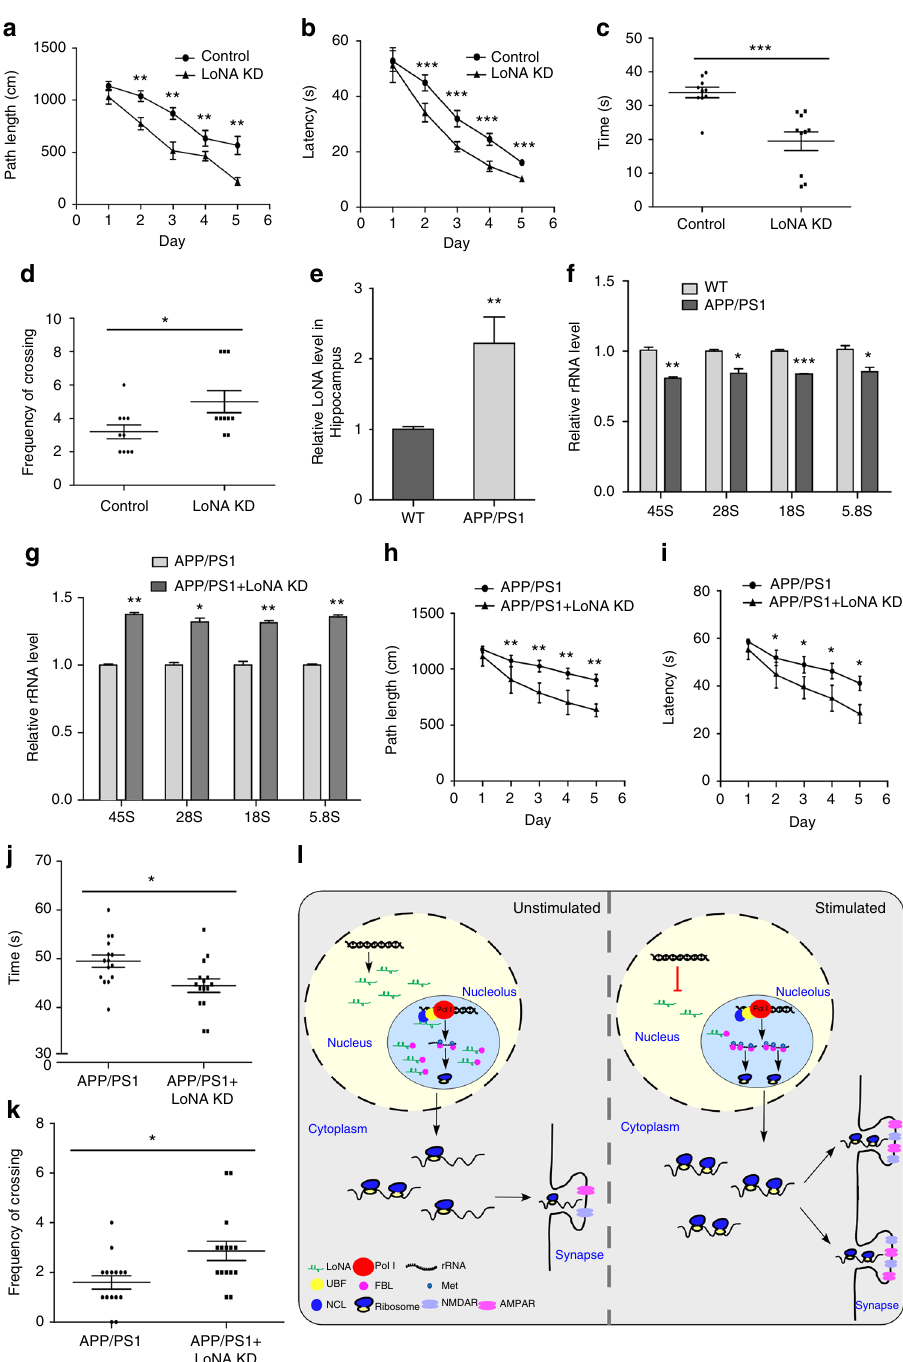
Fig. 6 LoNA de fi ciency in hippocampal brain leads to enhanced learning and memory in WT mice, and restored learning and memory de fi cits in APP/PS1 mice. a – d In the Morris water maze test, LoNA hippocampal knockdown mice entered the target quadrant with signi fi cantly lower travel distance ( a ) and less travel time ( b ) during the training phase ( n = 10 for each group). These mice took signi fi cantly less time to locate the hidden platform ( c ) and more frequently crossed the target quadrant ( d ) during the probe trial ( n = 10 for each group). e Expression levels of LoNA in the hippocampal brain of APP/PS1 transgenic mice were increased, as determined by qPCR (age of 8 month, n = 7 for each group). f pre- and mature rRNAs in the hippocampal brain of APP/ PS1 transgenic mice were downregulated, as determined by qPCR (age of 8 months, n = 7 for each group). g Pre- and mature rRNA levels in the hippocampal brain of LoNA-de fi cient APP/PS1 transgenic mice were restored, as measured by qPCR (age of 8 months, n = 10 for each group). h – k Hippocampal LoNA shRNA-administered APP/PS1 mice exhibited improved behavior in Morris water maze test. These mice entered the target quadrant with signi fi cantly lower travel distance ( h ) and less travel time ( i ) during the training phase (age of 8 months, n = 10 for each group). These mice took signi fi cantly less time to locate the hidden platform ( j ) and more frequently crossed the target quadrant ( k ) during the probe trial (age of 8 months, n = 10 for each group). l Schematic representation for the proposed mechanism underlying LoNA-controlled translational regulation and rRNA biogenesis. In this fi gure, error bars, s.e.m.; * P < 0.05; ** P < 0.01; *** P < 0.001 by ANOVA or two-tailed Student ’ s t